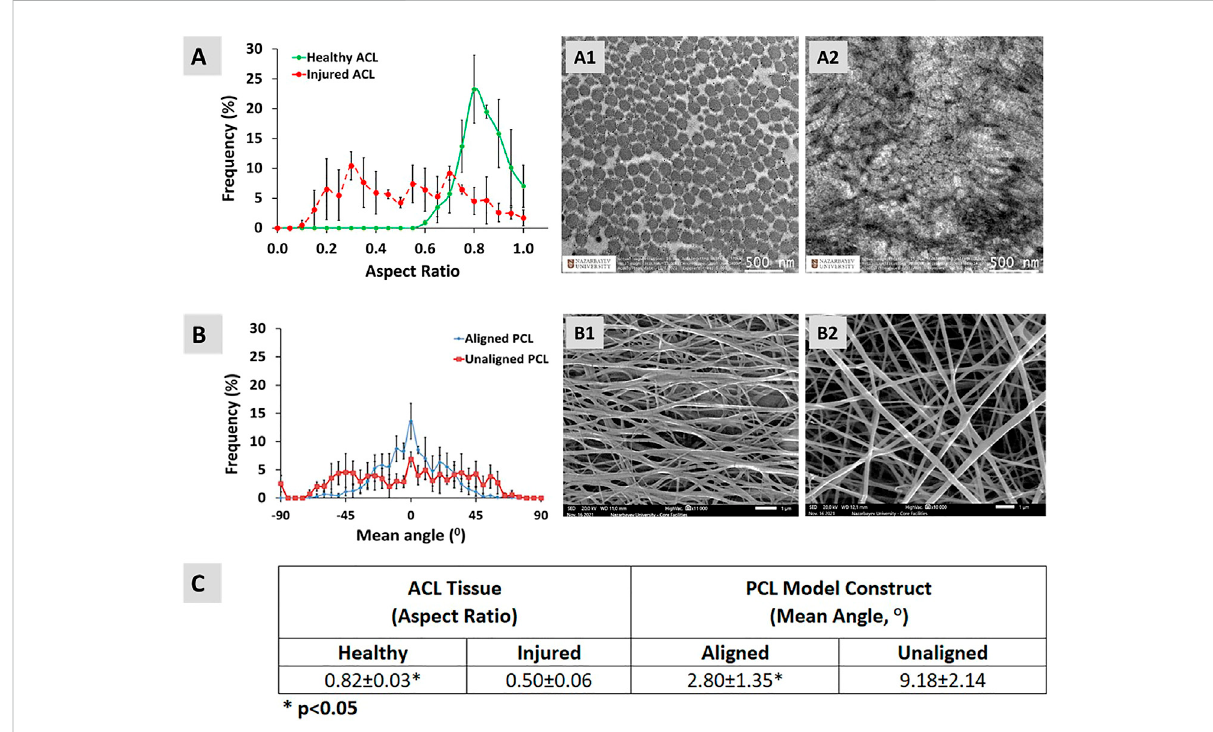
FIGURE 7 Alignment of (A) healthy and injured collagen fi brils in native ACL tissue (in the form of fi bril cross-section aspect ratio), (B) PCL fi bers, and (C) comparisonbetweenthepairs.Errorbarsrepresentstandarddeviation( n =3). (A1,A2) aretherepresentativeTEMimagesforhealthyandinjuredACL tissue, respectively. (B1,B2) are the representative SEM images for aligned and unaligned PCL model constructs, respectively.